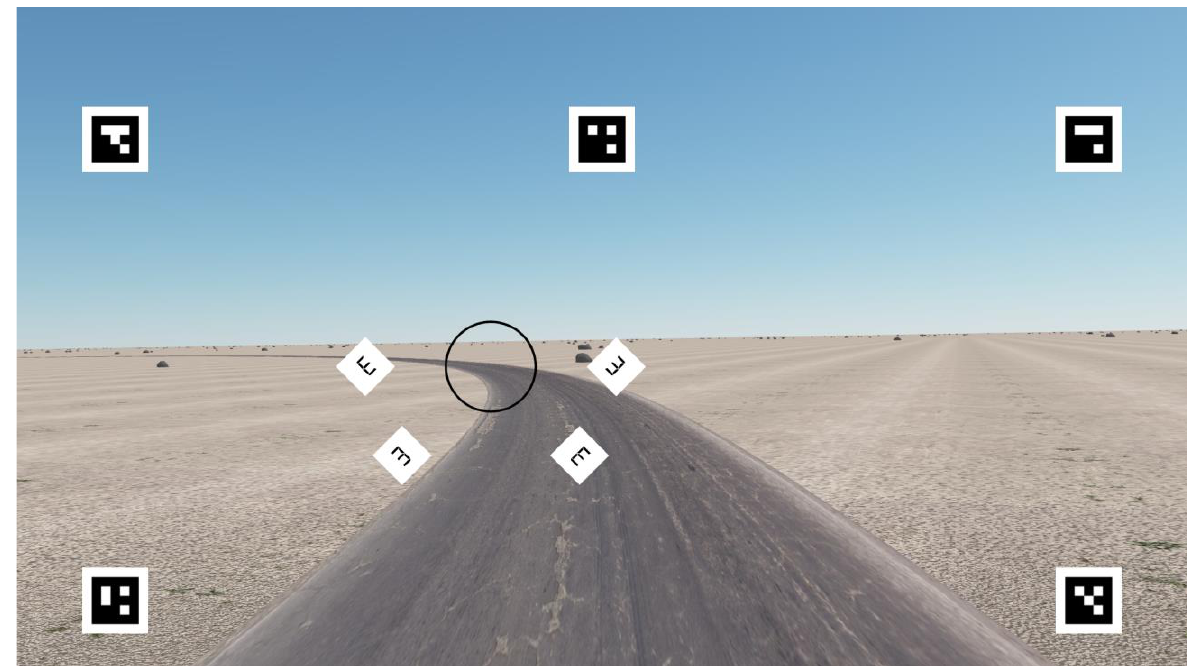
Figure 3. Screen capture from the steering task, showing the fixation circle, target locations (white diamonds) sur- rounding it, with a target (in the HI-BEND position) and three distractors. The square screen markers around the edges were used to detect the screen from the image of the eye tracker's front camera and determine a transformation from the camera coordinates to the screen